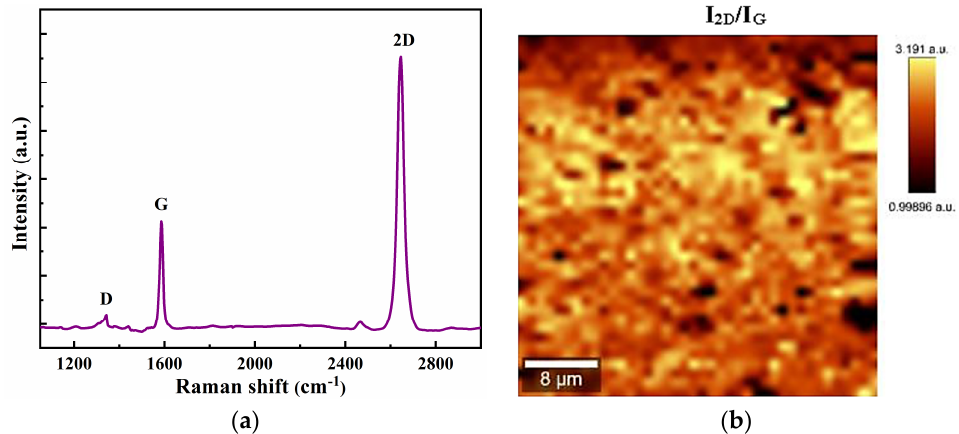
Figure 2. ( a ) Raman spectra of monolayer graphene transferred on SiO 2 /Si substrate; ( b ) 2D to G peak intensities ratio (I 2D /I G ) mapping.